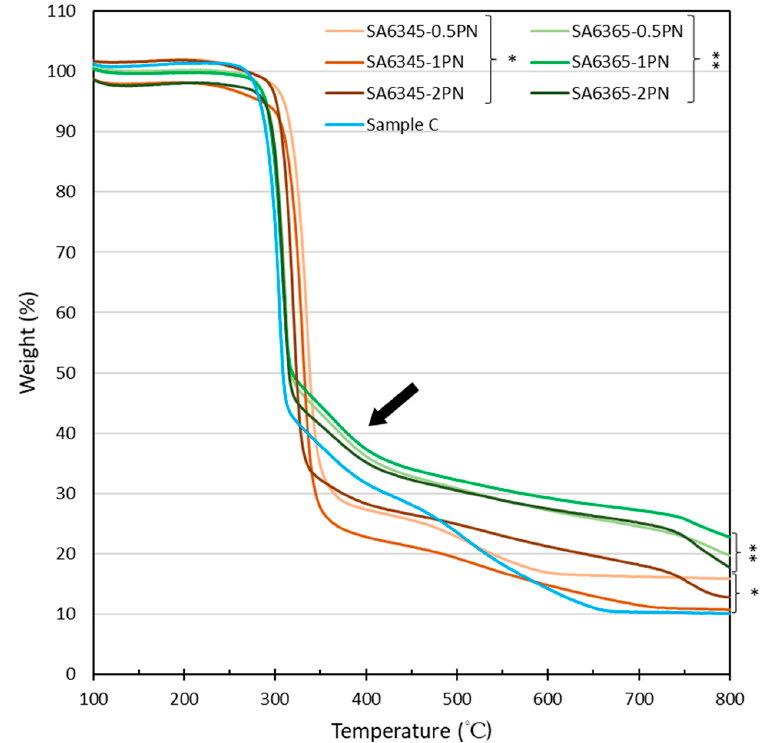
Figure 11. TGA diagram of all samples: P-CNCs obtained through hydrolysis at 65 °C (marked as “**”) and 45 °C (marked as “*”).